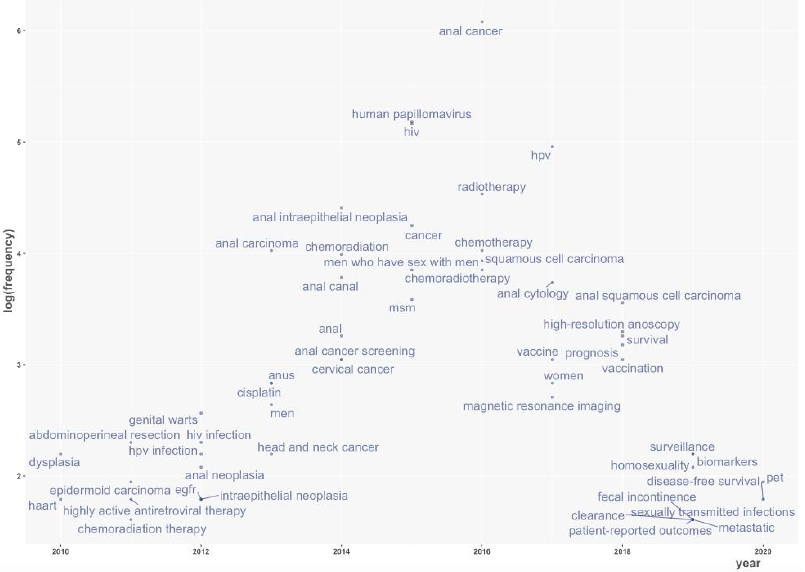
Figure 4. Trend topics in the last 10 years. The graph represents the use of the most frequent keywords over time; the respective frequency (for the specific year) is displayed on a vertical axis in a logarithmic scale. Each keyword is marked on the year with its highest prevalence in the literature.